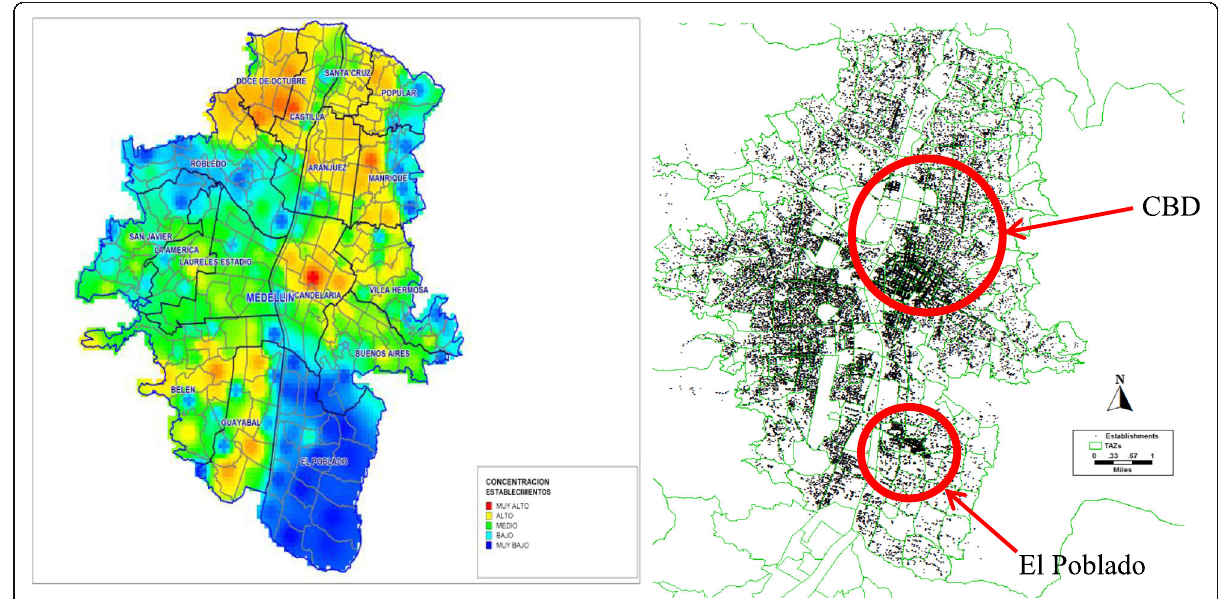
Fig. 1 Zoning system and location of commercial establishments in